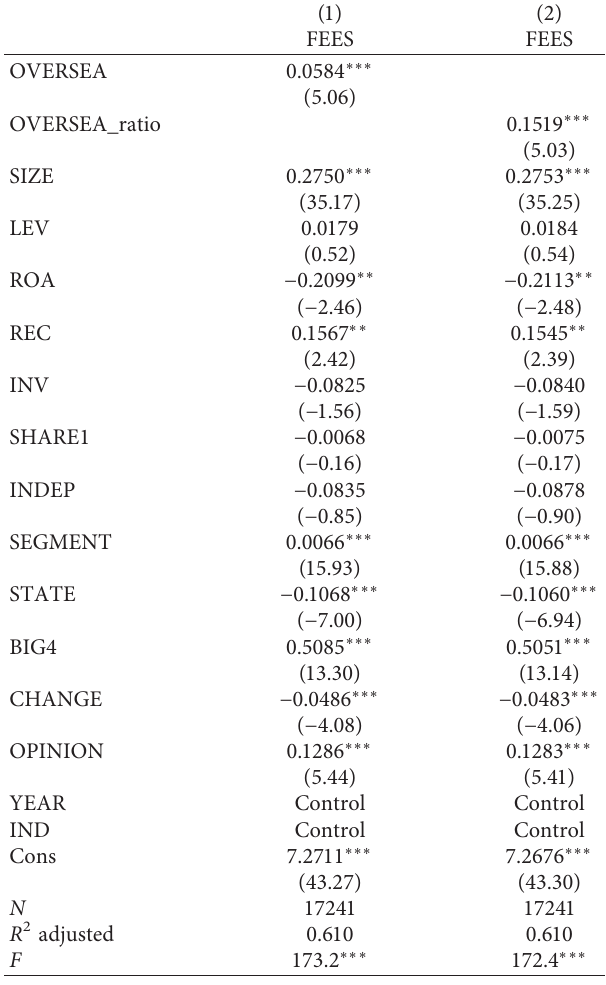
Table 6: Audit committee overseas experience and audit